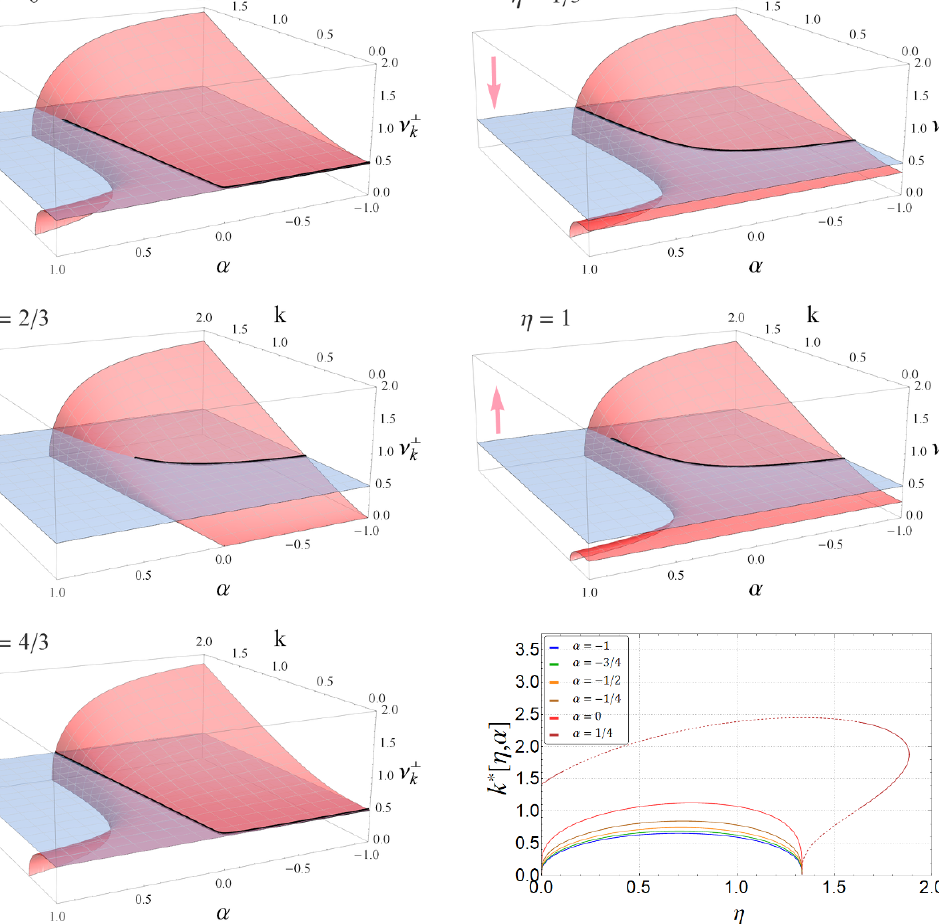
Figure 4. These (cid:12)gures elucidate the e(cid:11)ect of the background metric parameter (cid:17) and the Chern- Simons coupling on the exponent (cid:23) ? . In the 3D plots, (cid:23) ? is plotted with the (cid:23) ? = 1 = 2 plane, below which spectral weight exists (that is, (cid:27) ( k ) / ! 2 (cid:23) ? k (cid:0) 1 ! 1 ). As (cid:17) increases between 0 < (cid:17) < 2 = 3, the (cid:23) ? surface falls below the 1/2 plane. For (cid:17) > 2 = 3 the (cid:23) ? surface rises again. For (cid:17) > 4 = 3 no k k spectral weight exists. The bottom right plot shows how k (cid:3) changes for di(cid:11)erent values of (cid:11) . We see that k (cid:3) increases for increasing (cid:11) . For positive values of (cid:11) the theory can become unstable, and these regions are indicated by dashed lines on the (cid:11) = 1 = 4